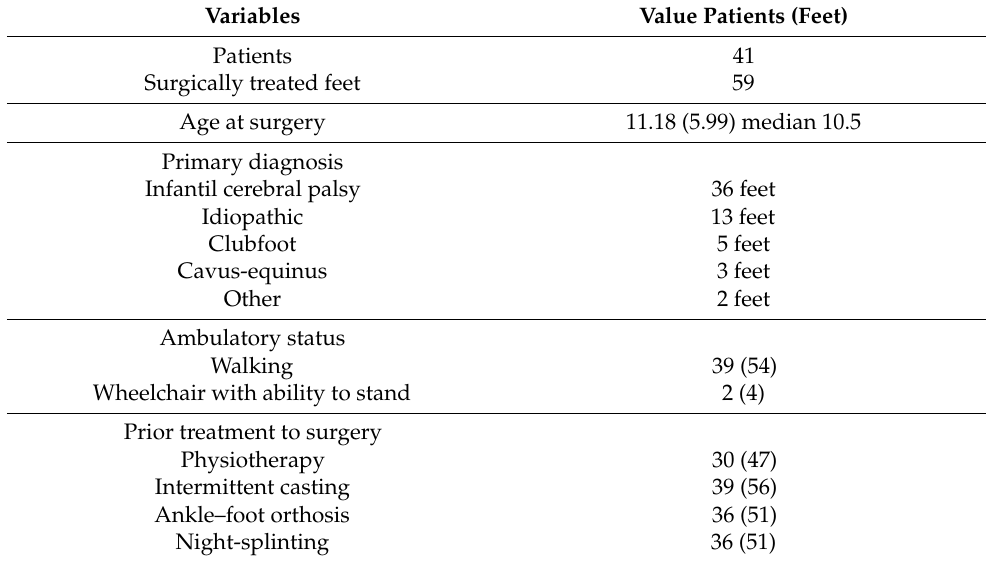
Table 1. Patient